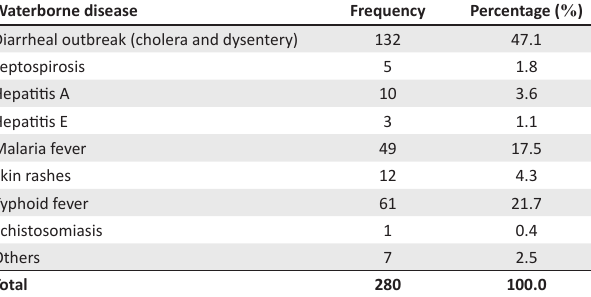
TABLE 1: Result of questionnaire showing major waterborne disease outbreak experienced in Ajegunle. Waterborne